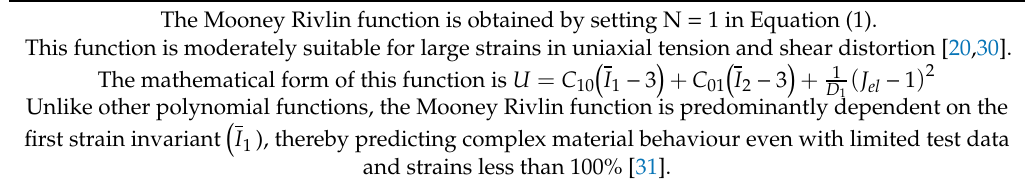
Table 1. Summary of the SEFs considered in this study